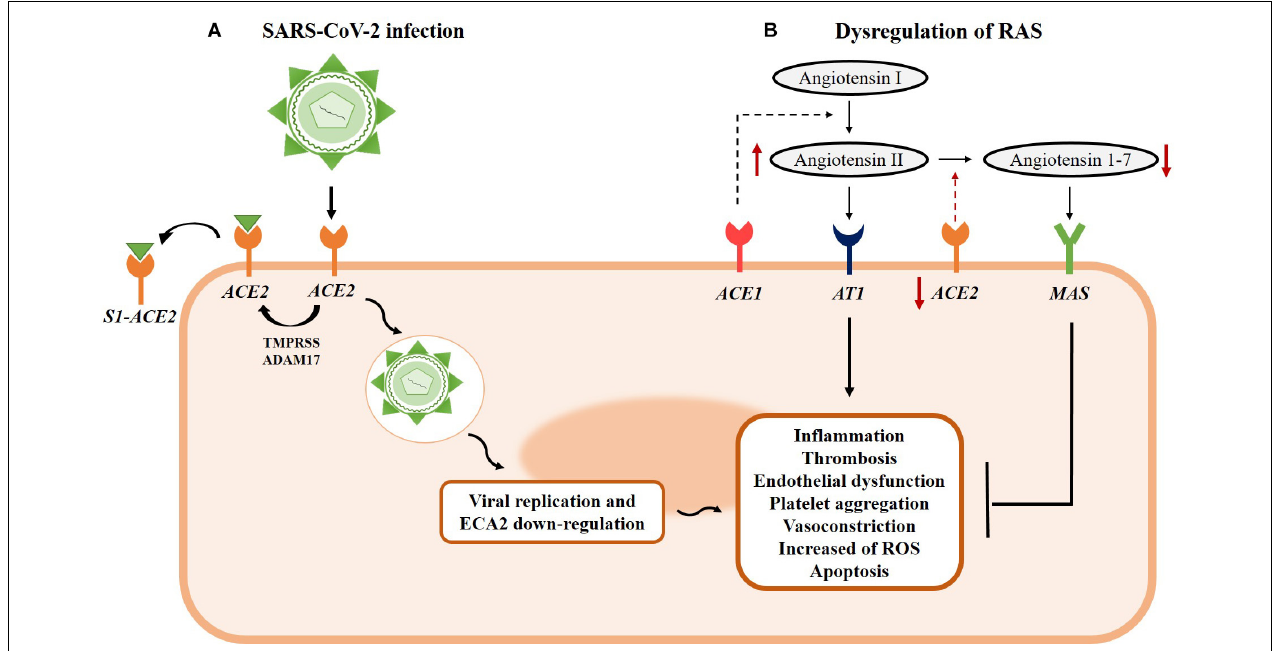
FIGURE 1 | Mechanism of Severe Acute Respiratory Syndrome Coronavirus 2 (SARS-CoV-2) infection and RAS system dysregulation. (A) SARS-CoV-2 uses the ACE2 receptor to enter human cells. Spike proteins can be cleaved by different host proteases to bind to ACE2 receptors. The S1-ACE2 interaction triggers the cleavage of ACE2 through transmembrane protease, serine 2 (TMPRSS) proteases or by ADAM17/TACE, resulting in the release of S1-ACE2 interaction from the host cells. The S1 angiotensin-converting enzyme 2 (ACE2) complex is followed by membrane fusion and subsequent viral endocytosis, which releases the viral genome into the cytoplasm, ACE2 downregulation, and pathological cellular effects. (B) The SARS-CoV-2 infection process contributes to RAS dysregulation due to ACE2 downregulation and, consequently, reduced conversion of Ang 1–7 from angiotensin II (Ang II) and increased levels of Ang II. The balance between ACE1 and ACE2 is necessary to maintain physiological conditions and the production levels of Ang II and Ang 1–7, respectively. The Ang II/AT1 interaction results in long-term exacerbated vasoconstriction, inflammation, thrombosis, and epithelial dysfunction. On the other hand, the Ang 1–7/MAS complex counteracts the harmful effects of Ang II by inducing vasodilation, anti-inflammatory effects, and tissue repair. In SARS-CoV-2 infection, the upregulation of Ang II leads to several long-term detrimental effects, while the lack of Ang 1–7 reduces the protective and counter-regulatory activities of the effects triggered by Ang